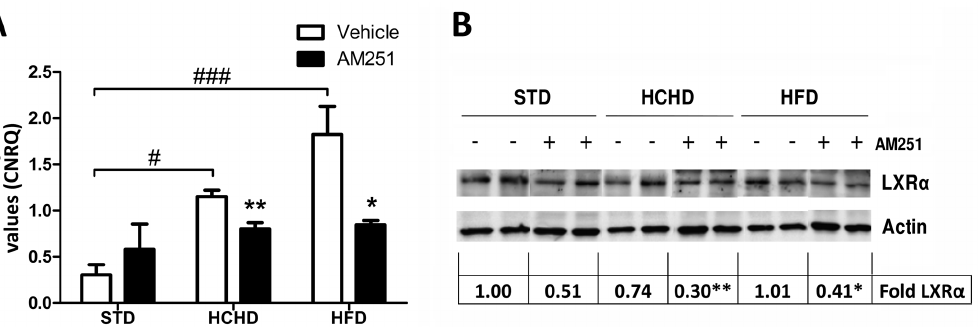
Figure 3. Effect of obesogenic diets and AM251 on the expression of the Lxr a transcription factor in PrAT. The Lxr a gene expression was determined in PrAT of STD, HCHD or HFD-fed animals after 14-day exposure to vehicle or AM251 (3 mg/kg, daily, i.p.). Columns are CNRQ means 6 SEM (n=8 animals per group). Differences between diets were analyzed by one-way ANOVA and Bonferroni’s post-hoc test, and comparisons between groups treated with AM251 or vehicle were analyzed by Student’s t test. # p , 0.05 and ### p , 0.001 denote significant differences compared with the STD-fed group treated with vehicle. * p , 0.05 and ** p , 0.01 denote significant differences compared with the corresponding vehicle-treated group ( A ). Western blot analysis of the LXR a protein was determined in the three diet conditions treated with vehicle alone or AM251 (n=6 animals per group). Two samples of each group are shown as representative. Relative LXR a protein levels were determined by densitometry corrected for beta-actin. Levels of LXR a are expressed as the fold over the STD-vehicle treated group (set as 1) as indicated at the bottom of the blot. * p , 0.05 and ** p , 0.01 denote significant differences compared with the corresponding vehicle-treated group ( B ).